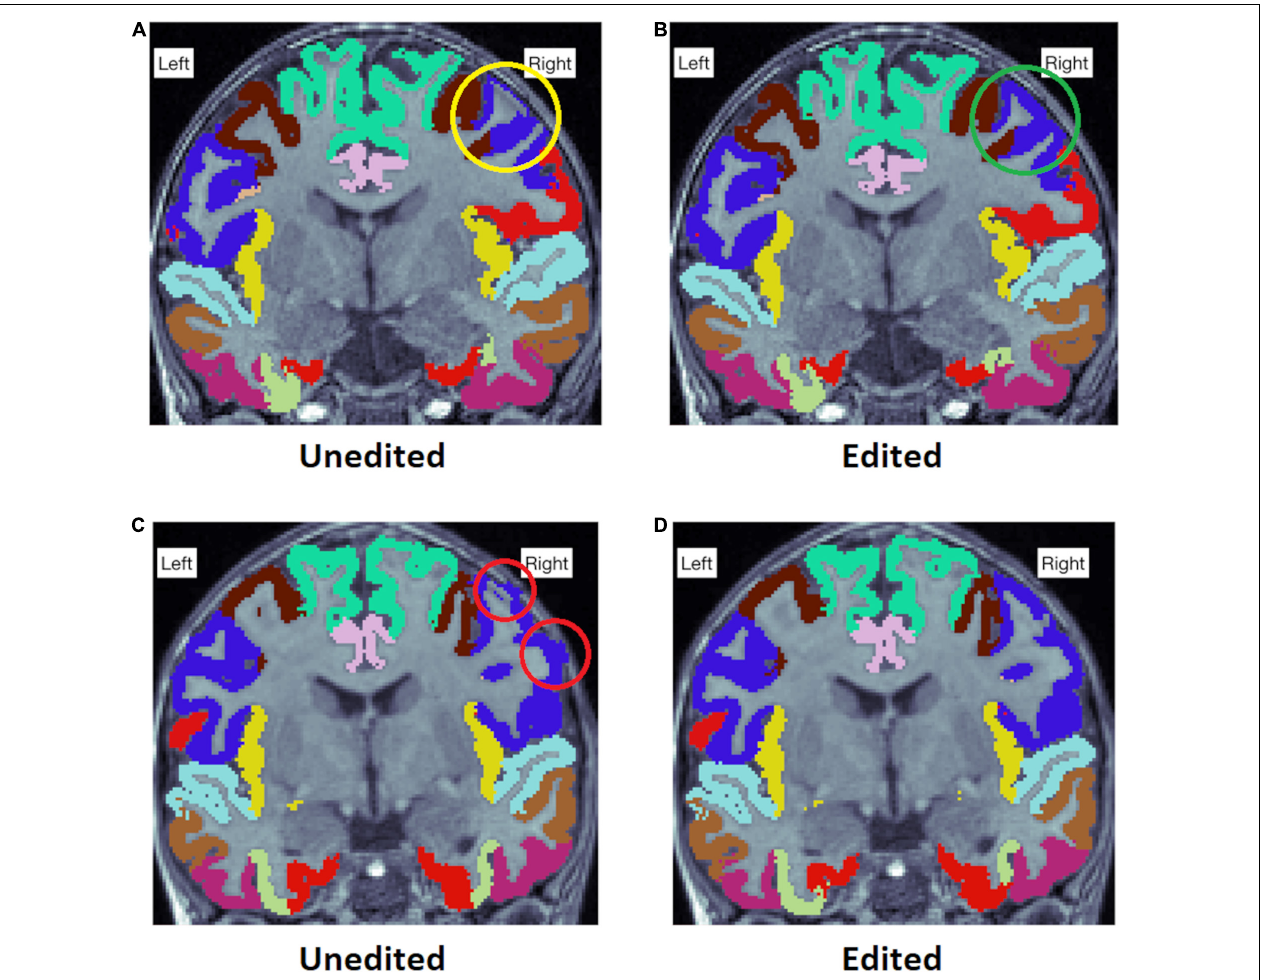
FIGURE 8 | (A) Shows an error in the right precentral gyrus, where the cortex is too thin (yellow circle). (B) is the edited image of the same participant, and the error is no longer visible in the region (green circle). In addition, (C) Shows the right precentral gyrus extending into the skull. (D) Shows the edited image of the same participant, where this error is no longer present. Notable, the right precentral gyrus is a region where significant differences between edited and unedited images were observed in cortical thickness and surface area